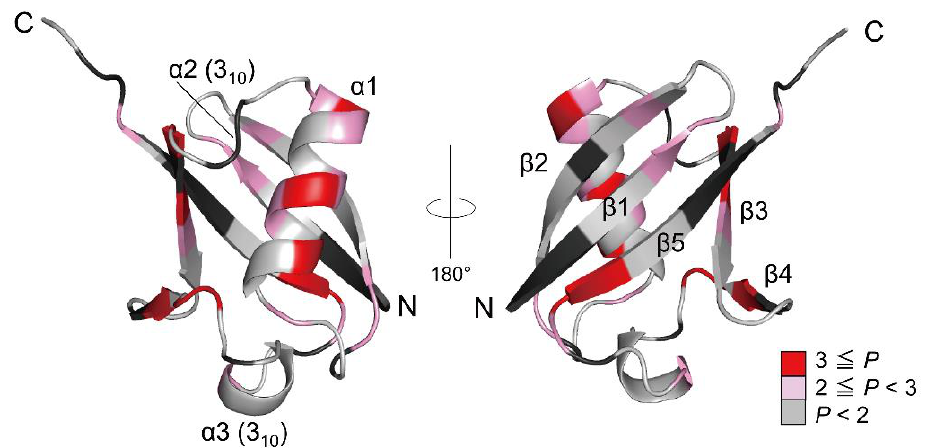
Figure 2. The 3D structure of native ubiquitin (PDB code: 1UBQ). The residues are colored according to the P values of the NH protons, and the red gradient indicates the scale of the P value. The proline residues and the residues that could not be used as probes due to severe broadening or overlapping are shown in black. Adapted with permission from Ref. [136]. Copyright 2020 Biophysical